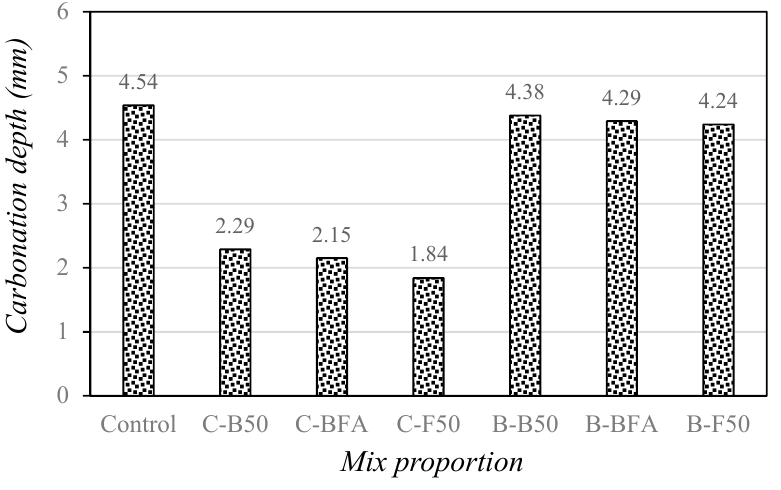
Figure 7. Changes in carbonation depth of mortar with mixed fine aggregates at 28 days.